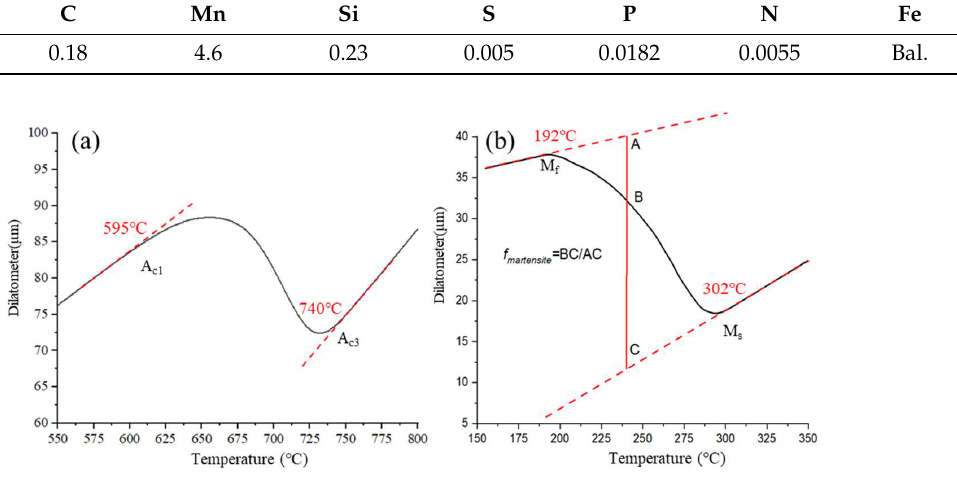
Figure 1. Temperature-Dilatometer curve ( a ) Heating stage; ( b ) Cooling stage.